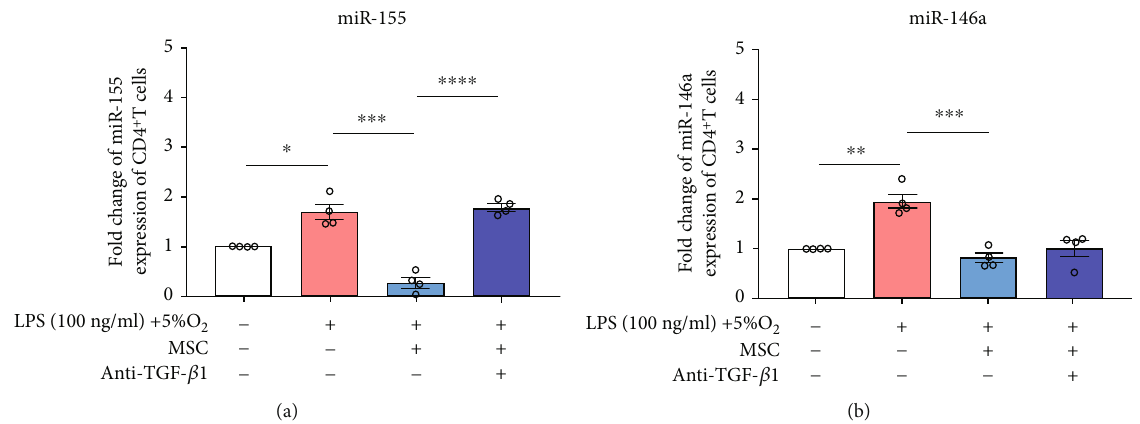
Figure 5: E ff ects of anti-TGF- β 1 neutralization on miR-155 and miR-146a expression of CD4 + T cells upon LPS and hypoxia challenge in response to MSC treatment. Bar graphs represent mean ± SEM levels of (a) miR-155 and (b) miR-146a expression detected by RT-PCR. ∗ P < 0 : 05 , ∗∗ P < 0 : 01 , ∗∗∗ P < 0 : 001 , and ∗∗∗∗ P < 0 : 0001 ( n = 4 ). LPS: lipopolysaccharide; MSC: mesenchymal stem cell; RT-RCR: real- time polymerase chain reaction; SEM: standard error of the mean; TGF: transforming growth